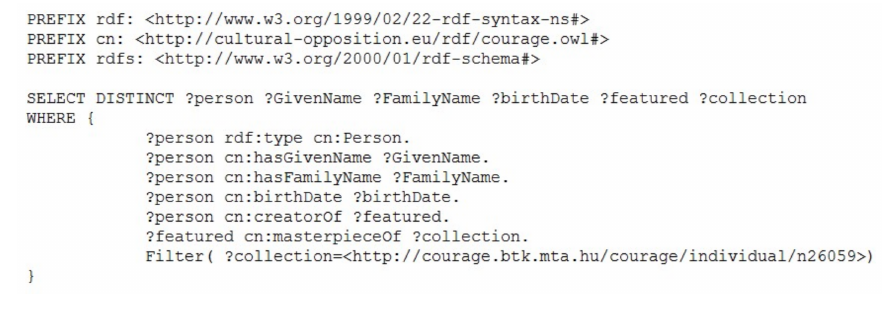
Figure 15. Sample query in COURAGE.